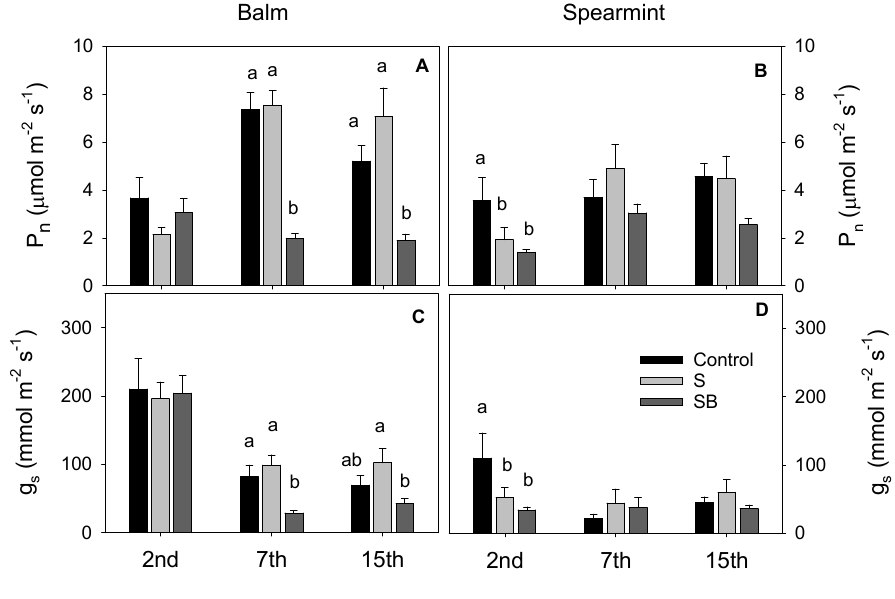
Figure 3. Net photosynthetic rate (Pn) ( A , B ) and stomatal conductance (gs) ( C , D ) in balm and spearmint plants irrigated with water from different sources. Bars without lowercase letters mean no significant differences between treatments. Different lowercase letters indicate significant differences between treatments according to Duncan’s test at p ≤ 0.05. Table 2. Leaf number, leaf area, leaf dry weight (DW) and root dry weight (DW) of balm and spearmint plants at 15th day. Values are mean ± S.E. of six